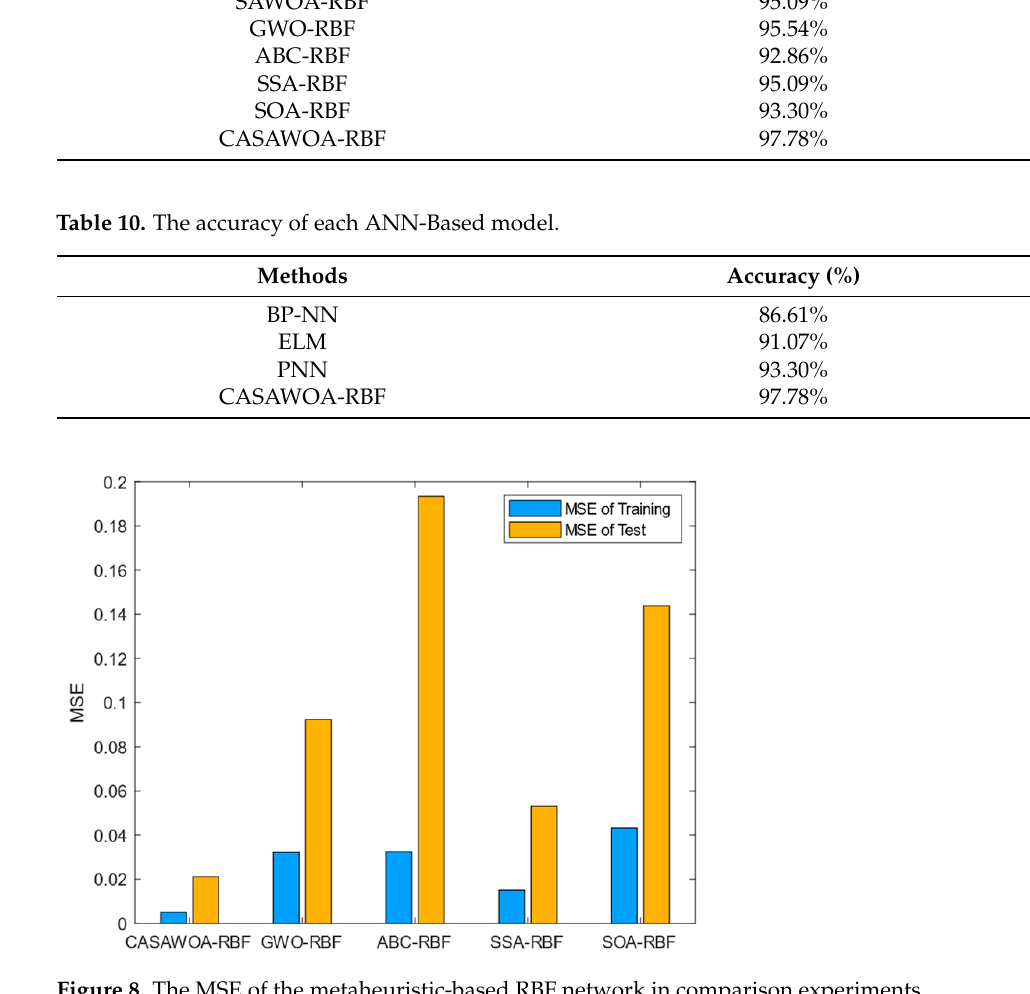
Figure 8. The MSE of the metaheuristic-based RBF network in comparison experiments.